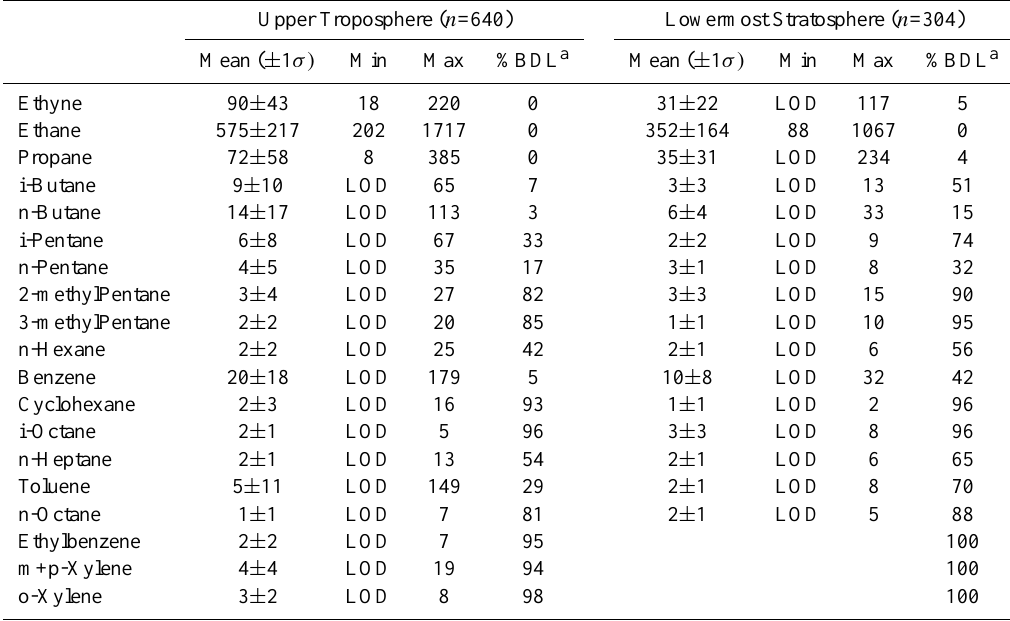
Table 4. Overview of NMHC results for both the upper troposphere and lowermost stratosphere. Mixing ratios are given in pptv. Upper Troposphere ( n